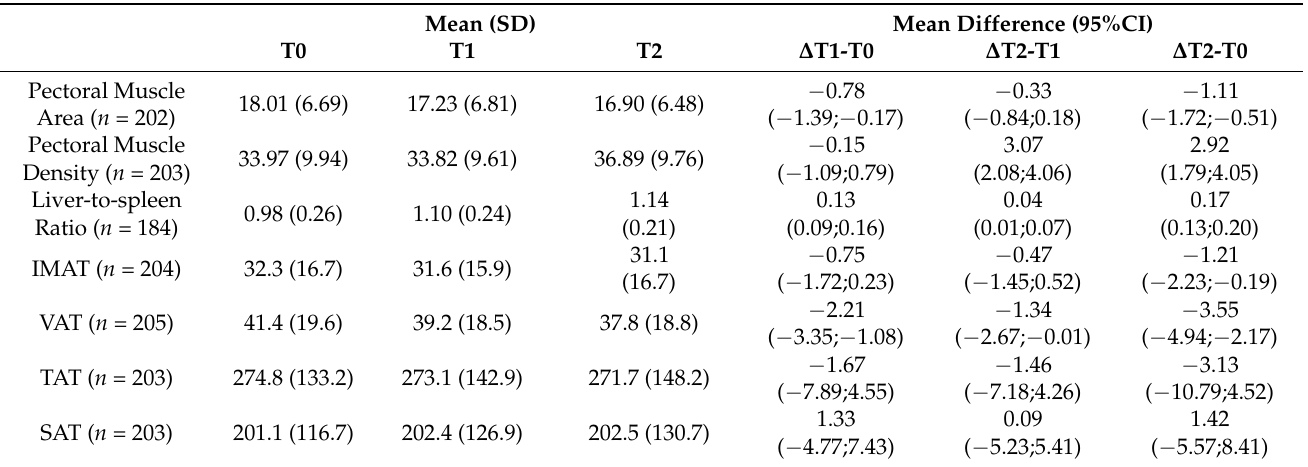
Table 2. Chest CT body composition parameters at each time point and respective changes between different time